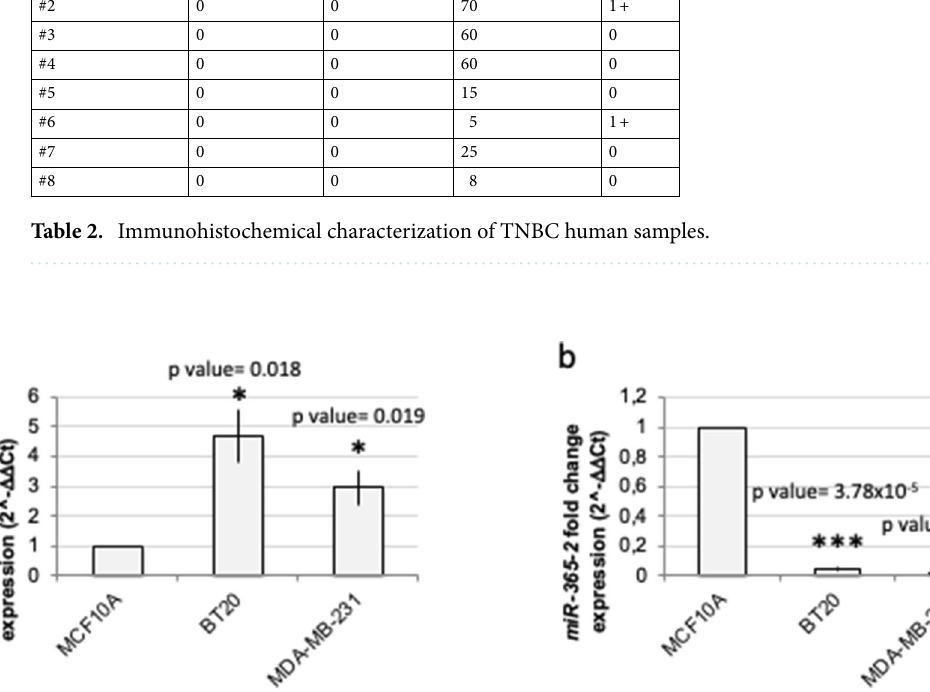
Figure 2. Validation of miRNA expression in MDA-MB-231 basal cell line model. miR-135b ( a ), and miR-365- 2 ( b ) expression levels were evaluated by RT-qPCR analysis in BT20 and MDA-MB-231 cell lines compared with normal-like MCF10A cells. The results are the average of three independent experiments. T test p value < 0.05 (*), 0.01 (**), 0.001